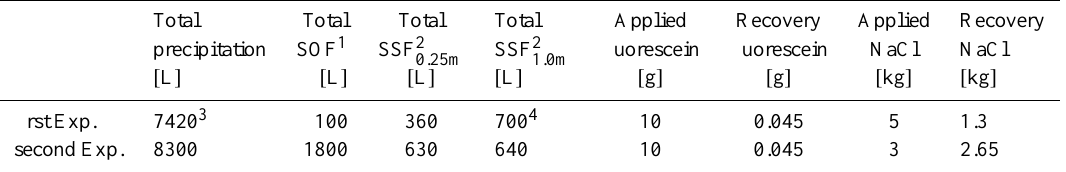
Table 2. Summary of the total precipitation, total flow, and total applied tracer masses ( fluorescein : line tracer injection in topsoil; NaCl